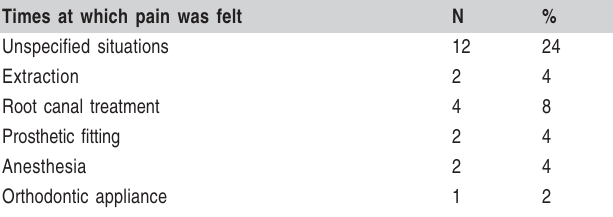
Table 3 – Situations reported by patients with pain.